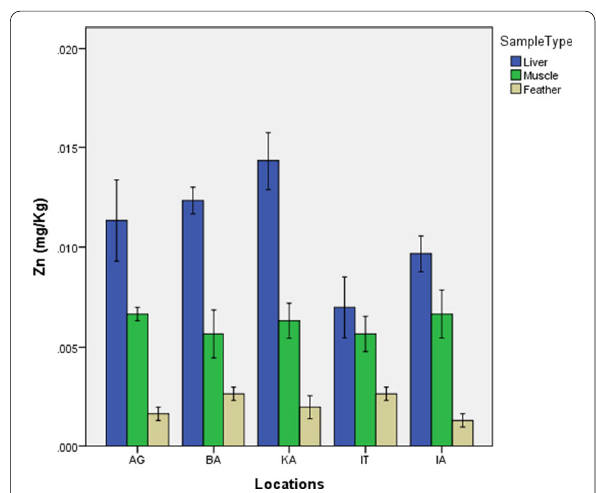
Fig. 6 Level of zinc (Zn) in sampling locations